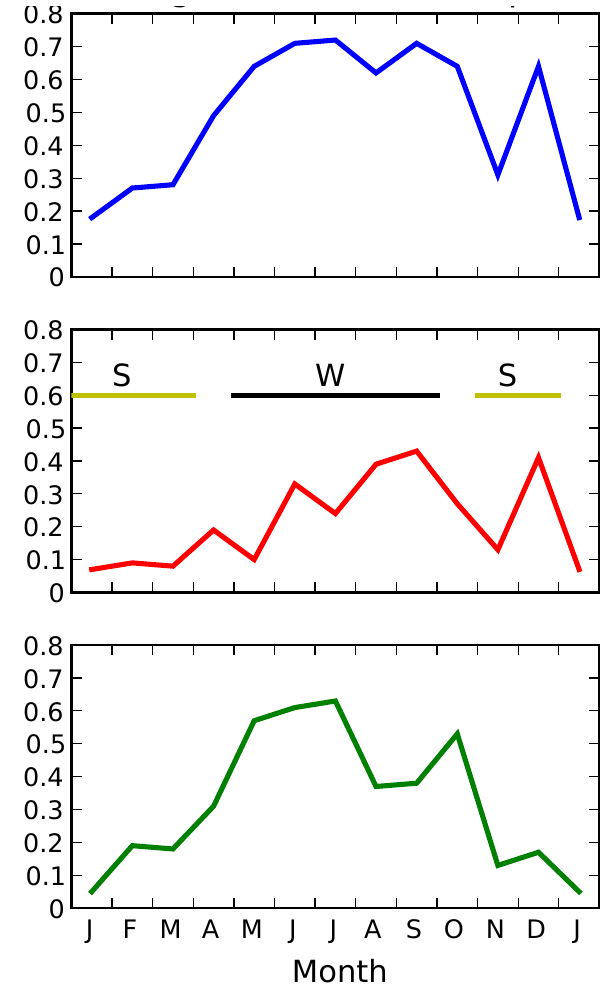
Fig. 2b. Seasonal variation of the ratio “event incidence/ A p (m)”, where A p (m) is the monthly mean of A p